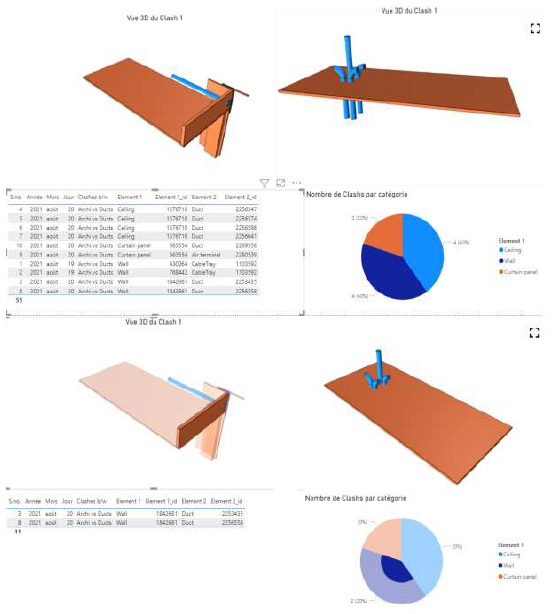
Figure 8. Clash coordination dashboard